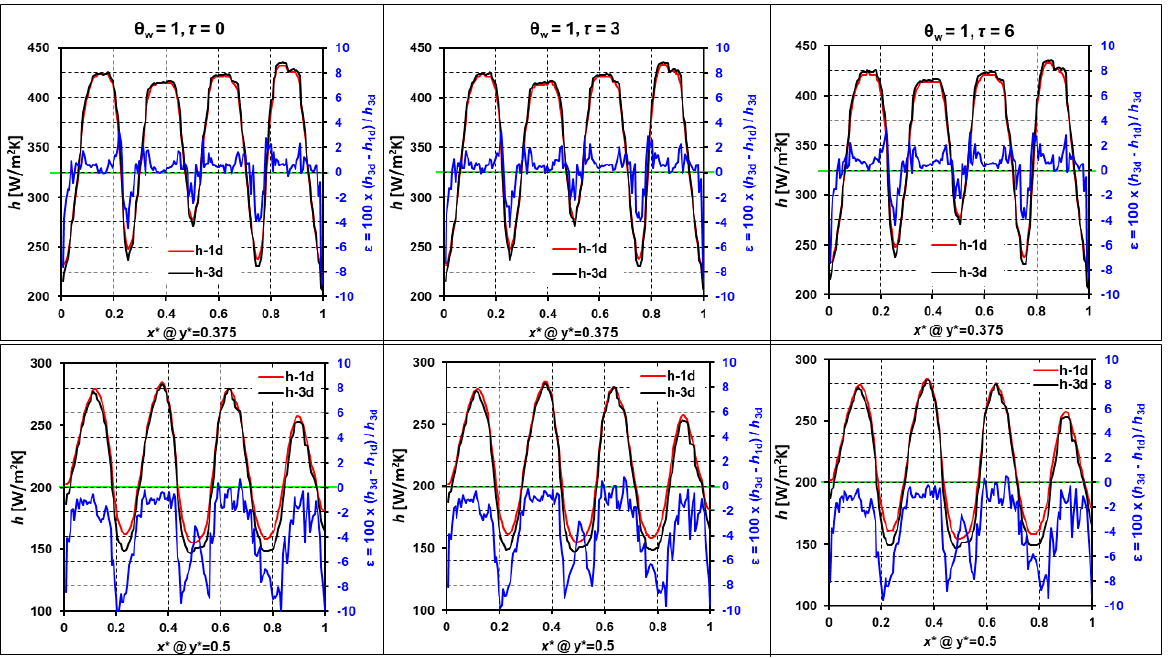
Figure 7. Method A, Case III: Local h variation with x* at y* = 0.375 and y* = 0.5 (see Figure 1) and their relative % differences.